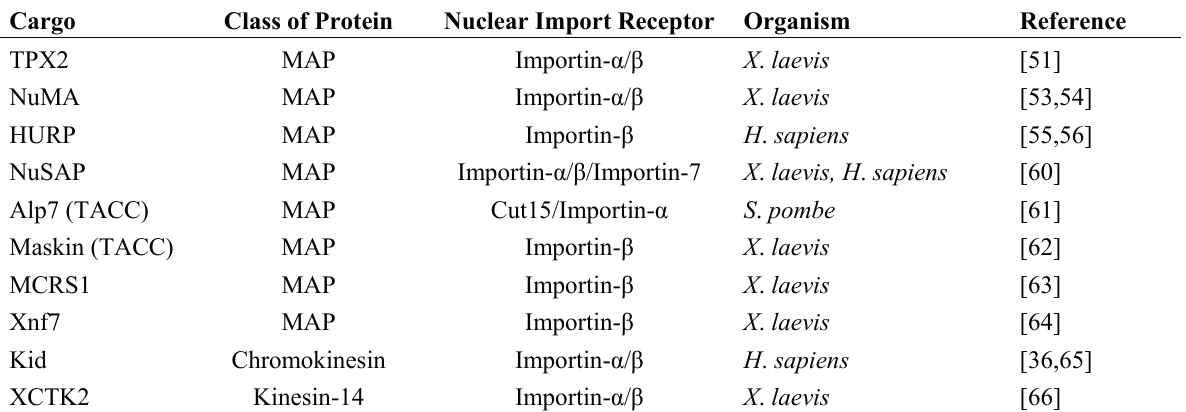
Table 2. List of microtubule-associated proteins targeted by Ran